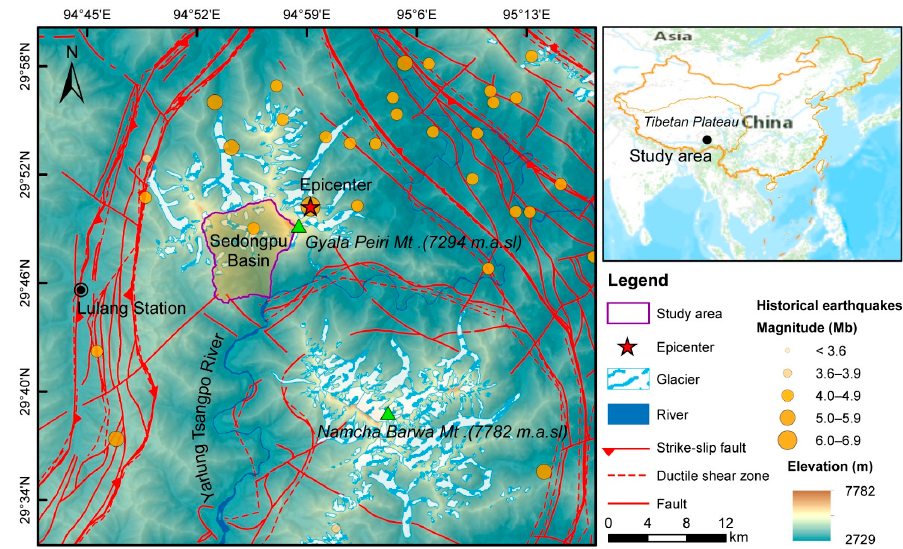
Figure 1. Geographic location and main surrounding tectonic features of the Sedongpu Basin in southeastern Tibet. The geologic structure of the study area was derived from a 25 W geologic map provided by the National Geological Archives of China (http://www.ngac.org.cn/, accessed on 5 May 2022). The circles represent earthquakes and aftershocks that occurred since 1950, and the historical seismic data were obtained from the USGS (https://earthquake.usgs.gov/, accessed on 24 March 2022).